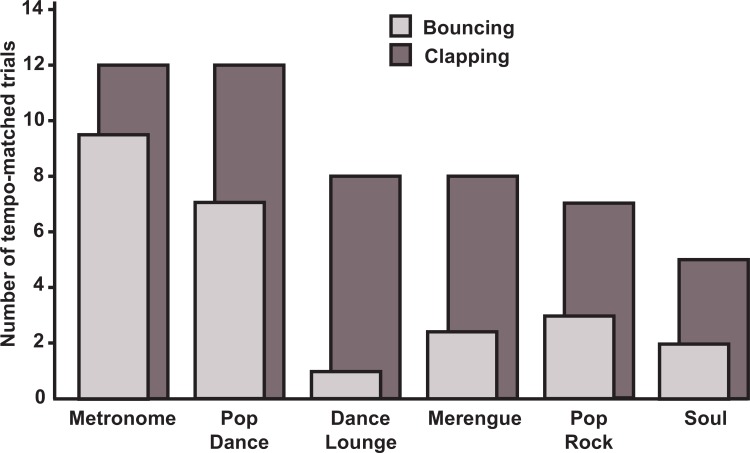
Period matching in Poor Synchronizers' group.We presented the number of success trials (i.e. period-matched), for each movement type and for all stimuli (maximum is 14, i.e. the number of poor synchronizers). The two Merengue and two Metronome were averaged.